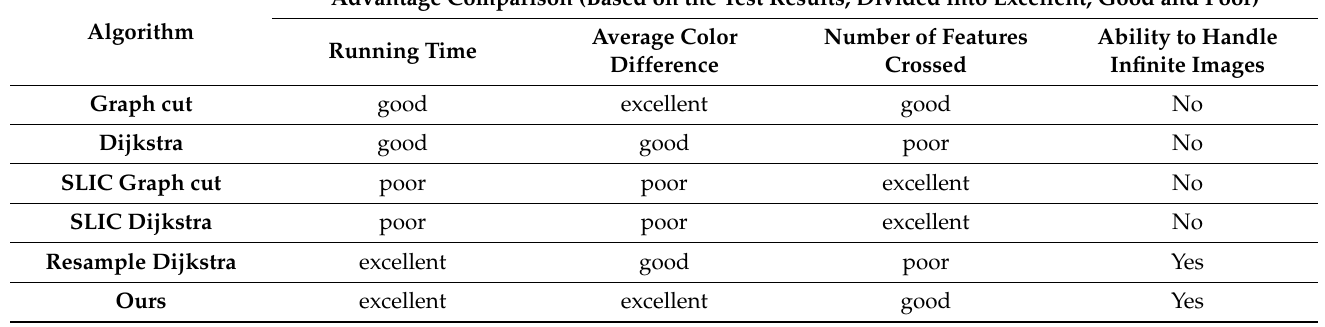
Table 4. Comparison of algorithm advantages and